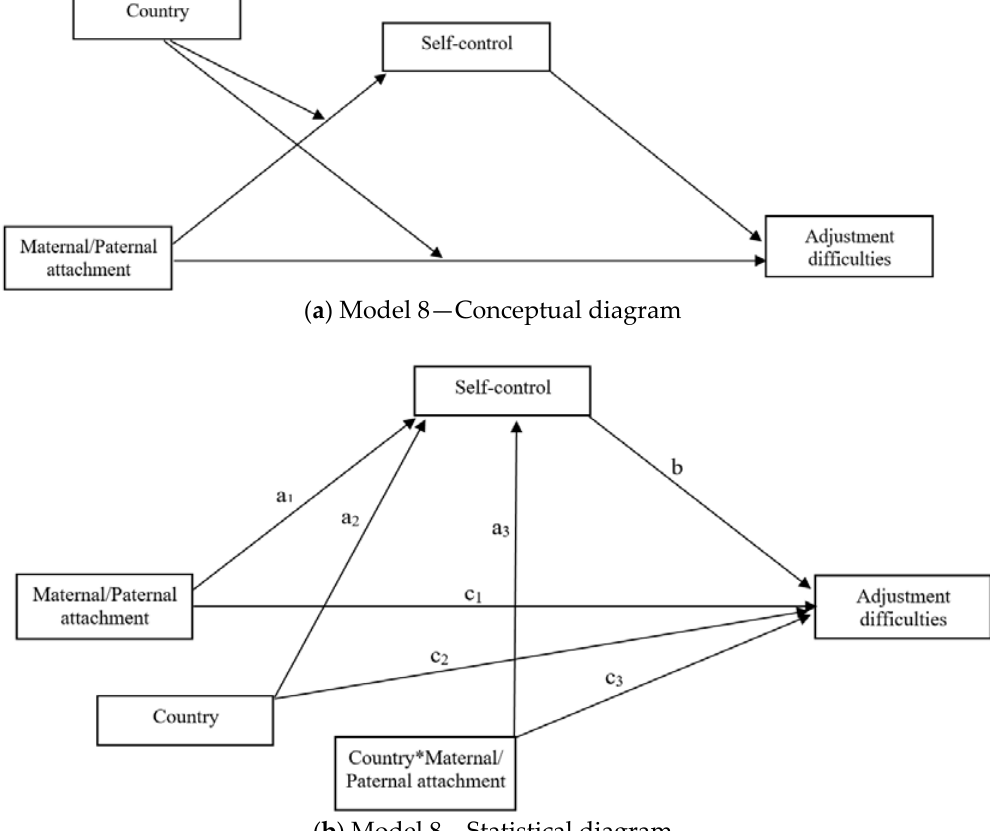
Figure 1. ( a , b ) Conceptual and statistical diagrams, PROCESS Model 8. Note. Country*Maternal/Paternal attachment = interaction effect between either maternal or paternal attachment (independent variables) and country (moderator) on both self-control (mediator) and adjustment difficulties (dependent variable).